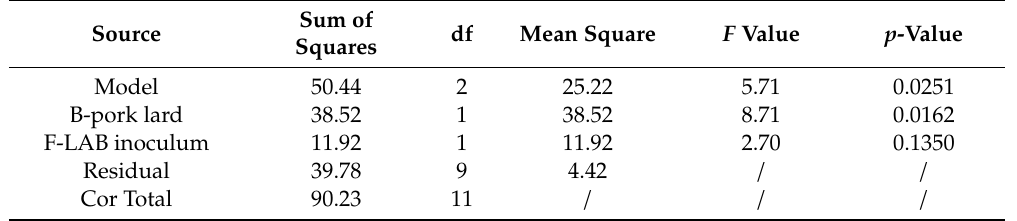
Table 6. ANOVA analysis of the e ff ect of the studied parameters upon the antioxidant activity of the fermented